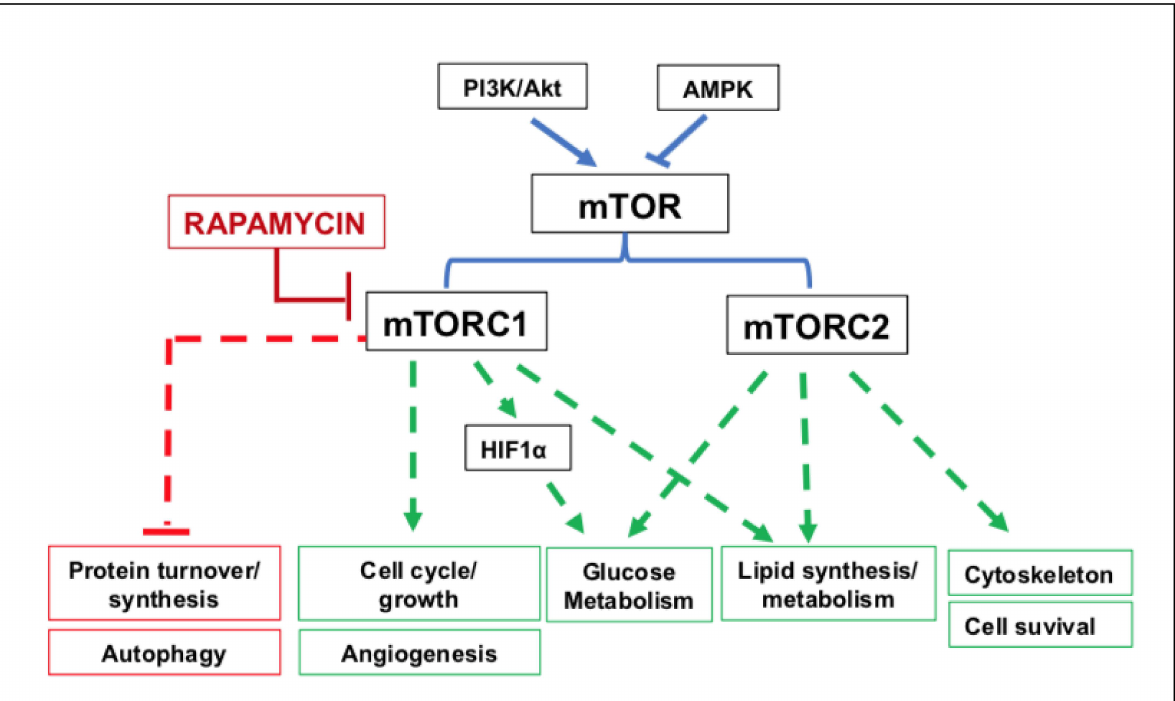
Figure 2. Scheme of the activities promoted by the mTOR (mammalian target of rapamycin) system, composed of two complexes known as mTORC1 and mTORC2, and of its modulation by the phos- phatidylinositol 3-kinase (PI3K) and AMP-activated protein kinase (AMPK) pathways. Rapamycin exogenously inhibits the mTOR system, mostly acting on the activities of mTORC1. Arrows drawn with dashed lines indicate that more downstream factors contribute to the final effect caused by the activation of mTORC1 and mTORC2. Abbreviation: HIF1 α , hypoxia-inducible factor 1 α